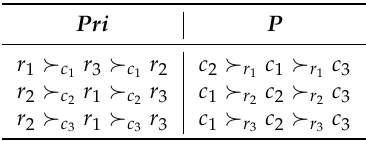
Table 2. Refugees’ preferences and priorities in Example